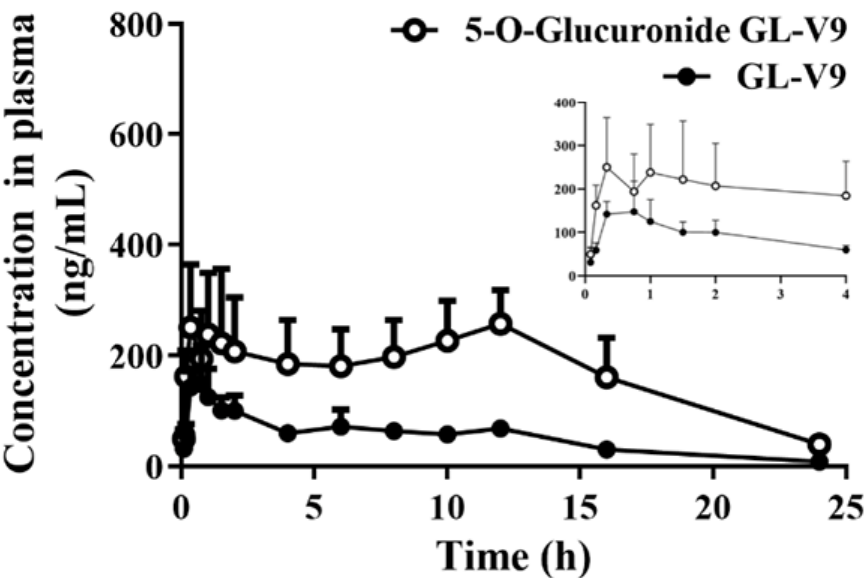
Figure 7. Mean concentration-time profiles of GL-V9 or 5- O -glucuronide GL-V9 in rat plasma after oral administration of GL-V9 (gavage, 50 mg / kg). Concentrations of GL-V9 or 5- O -glucuronide GL-V9 in rat plasma were quantified using UPLC-MS / MS. The concentration data of GL-V9 were reported by Xing et al. [38]. All the data were expressed as the average of six determinations and the error bar represents the standard deviation of the mean (mean ± SD, n = 6).